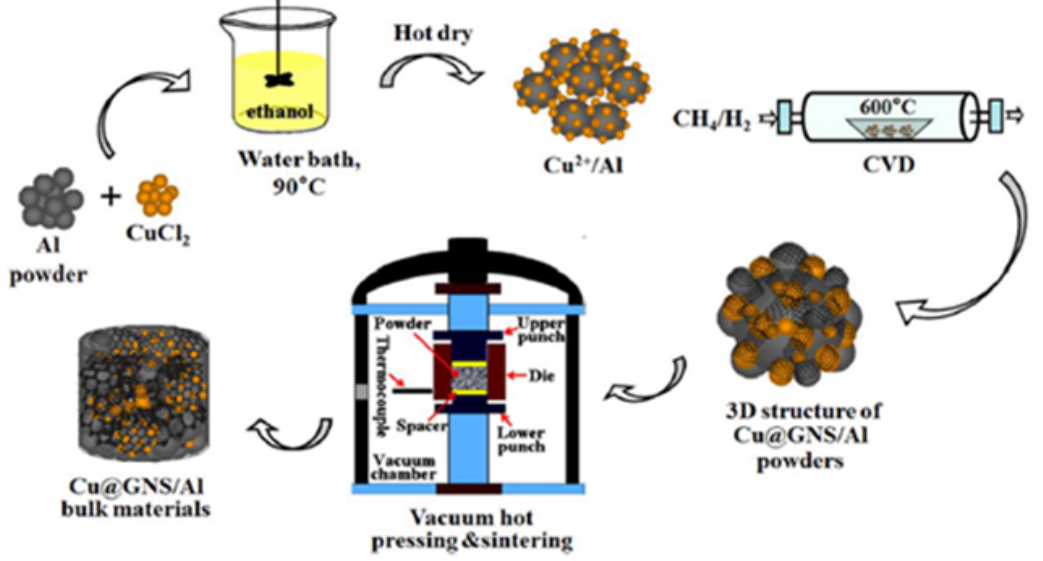
Figure 14: A schematic diagram of the preparation procedure of Cu-GNS-Al bulk composites. Reproduced from Reference